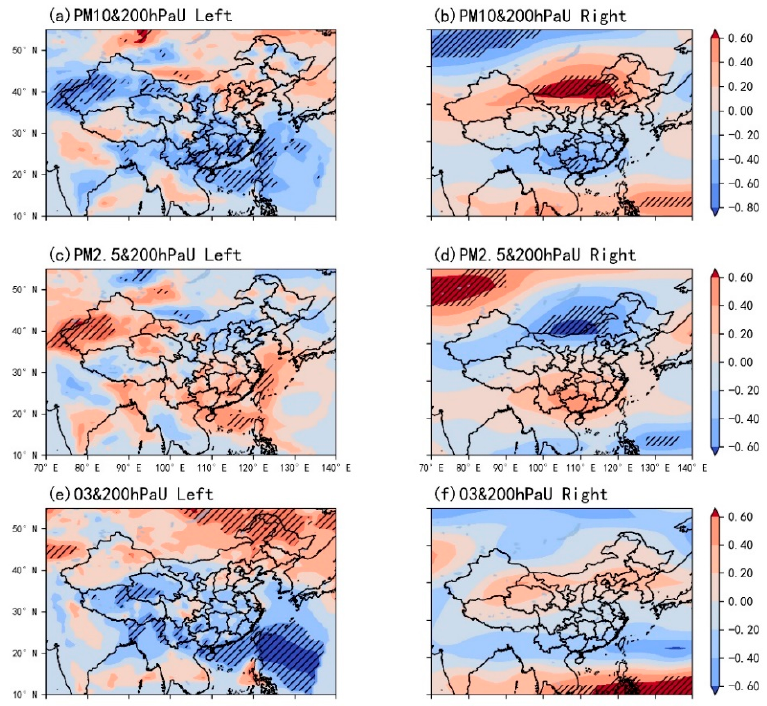
Figure 11. The ( a , c , e ) left and ( b , d , f ) right heterogeneous correlation diagrams of the SVD2 of the surface pollutants including the PM 10 , O 3 and PM 2.5 (the left field) and the 200 hPa zonal wind field (the right field) in summer from 2013 to 2018. The slashes indicate that the results passed the 95% Monte Carlo correlation test.